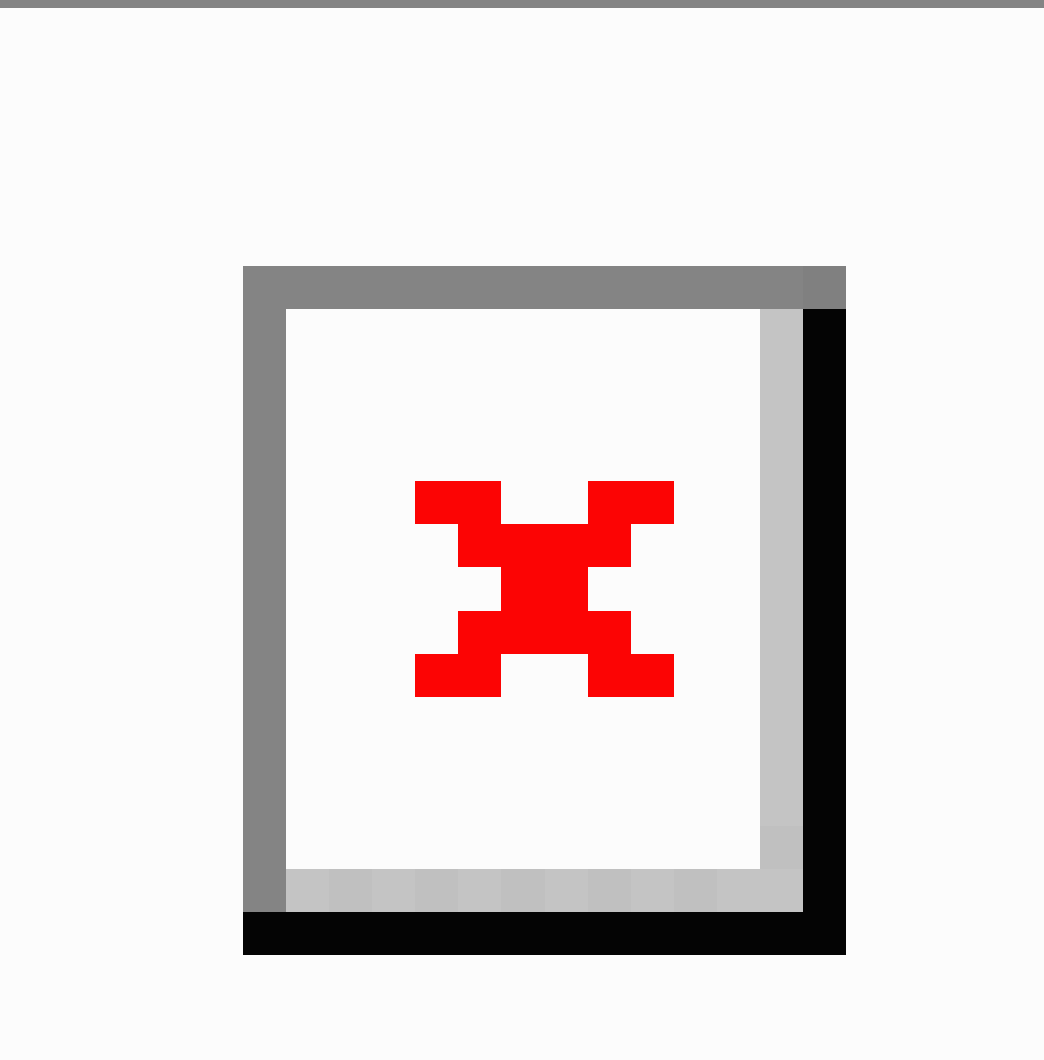
Figure 1. The mediation effect of mental distress due to COVID-19 on the associations between the independent variables and depression. The structural equation model was adjusted for background variables, including sex, school-related information, living arrangement during the Chinese Lunar New Year, self-reported physical health status, and information about localities of stay at the time of the survey. # indicates latent variables; details are described in the Methods of the text. PHQ-9: Patient Health Questionnaire-9. * P <.05; ** P <.01; *** P